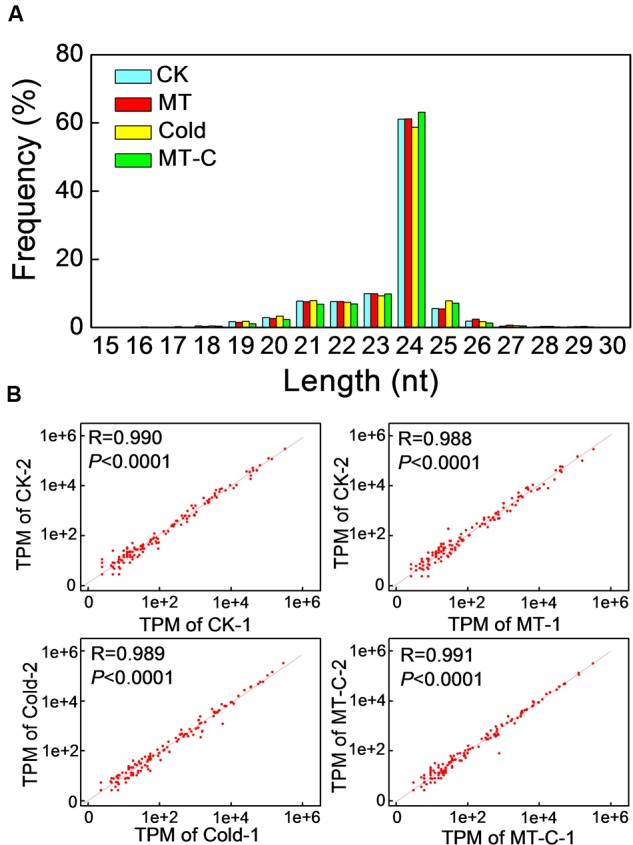
(A) Summary of the sequence lengths distribution and (B) the correlation between two biological repeats in melatonin or/and cold treatments. The plants were treated as described in Figure 1 and samples were harvested at 6 h after cold treatment.